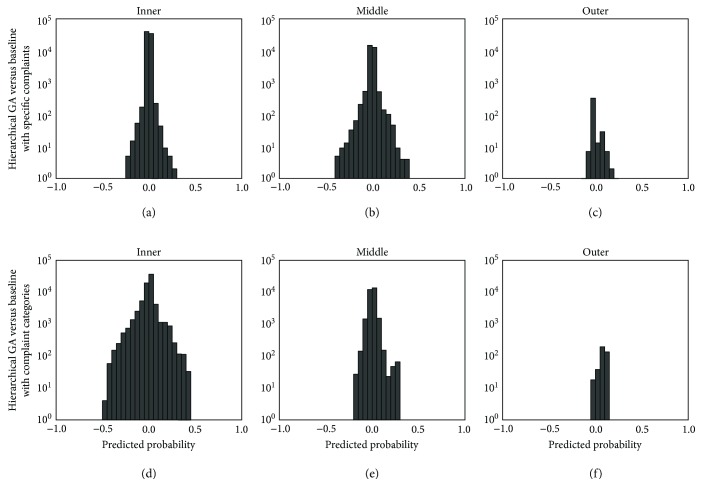
Histogram summary of differences in predicted probabilities of the hierarchical approach relative to baseline models. (a, b, c) Baseline model with complaints only. (d, e, f) Baseline model with categorized complaints only for the inner (a, d), middle (b, e), and outer subgroups (c, f) of patients. Note that the y-axis displays the frequency (count) of patients on a logarithmic scale.